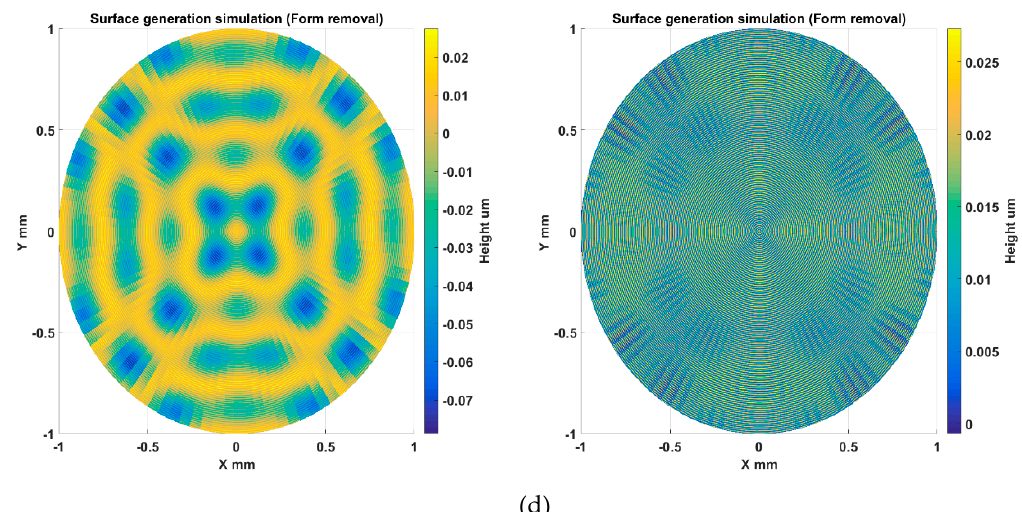
Figure 16. Simulation analysis of overcutting phenomenon and tool radius compensation (left column: without compensation, right column: with compensation): ( a ) Simulated surface generation; ( b ) Extracted radial profile topography; ( c ) Enlarged view of radial profile topography; ( d ) Simulated surface topography residual (after form removal).